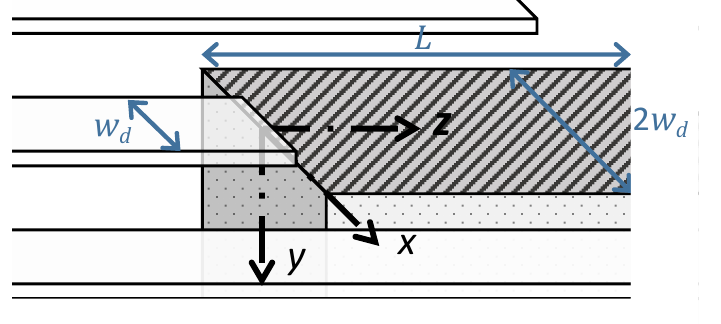
Figure 2. Interdigitated electrode (IDT) fingers and the piezoelectric substrate. The highlighted section represents the sector under